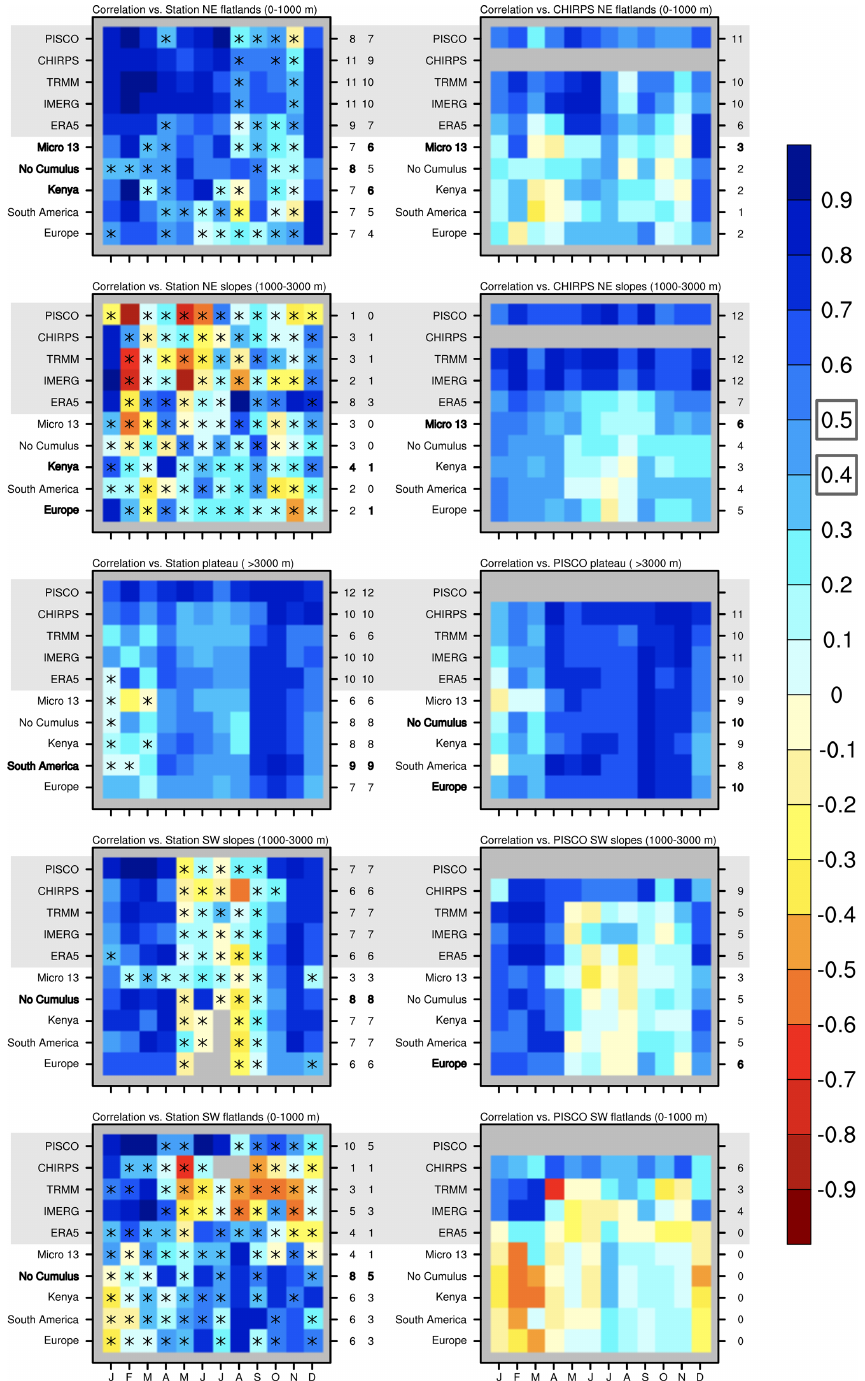
Figure 5. Spearman pattern correlation compared to weather stations data (left column) and compared to CHIRPS (first two rows, right column) and PISCO (last three rows, right column). The five rows represent stations and data points in the northeastern flatlands ( < 1000ma.s.l.), along the northeastern slopes of the Andes (1000–3000ma.s.l.), on the plateau ( > 3000ma.s.l.), along the southwestern slopes of the Andes (1000–3000ma.s.l.), and in the southwestern flatlands ( < 1000ma.s.l.), respectively. The light grey shading denotes satellite based or reanalysis data, and facilitates the separation from the WRF simulations. Asterisks inside the pixels indicate non signifi- cance at α = 5%. The numbers in the first column of the right y axis indicates the number of months that result in a correlation larger than 0.5 compared to weather station data (left panels) and 0.4 in comparison to PISCO data (right panels). These two moderate correlation values are boxed in the colour scale. The second column of the right y axis considers only months that are statistically significant (left panels only). The bold numbers and names indicate the best option for each